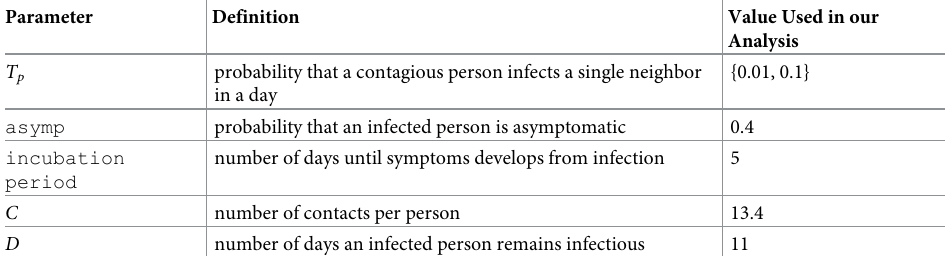
Table 1. COVID-19 parameters used in our analysis.